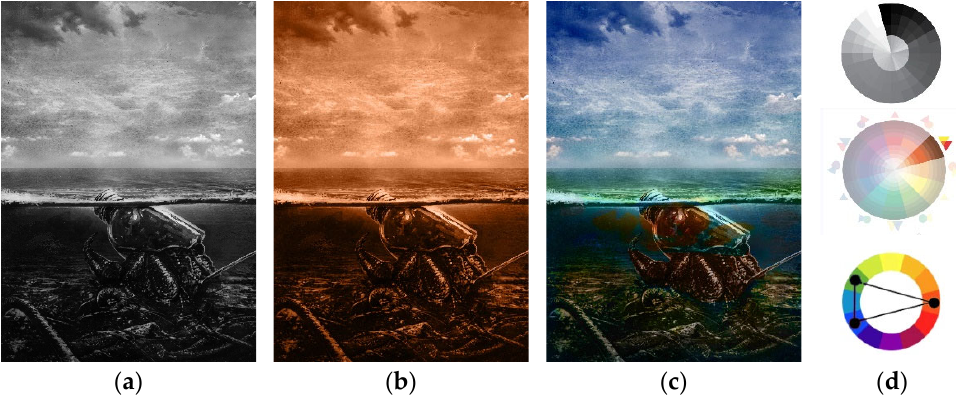
Figure 3. The artwork depicts the struggle of an abandoned hermit crab living in a broken energy drink bottle: ( a ) Black ‐ and ‐ white concept; ( b ) Monochrome concept; ( c ) Color concept; ( d ) Color wheel concept of each image.